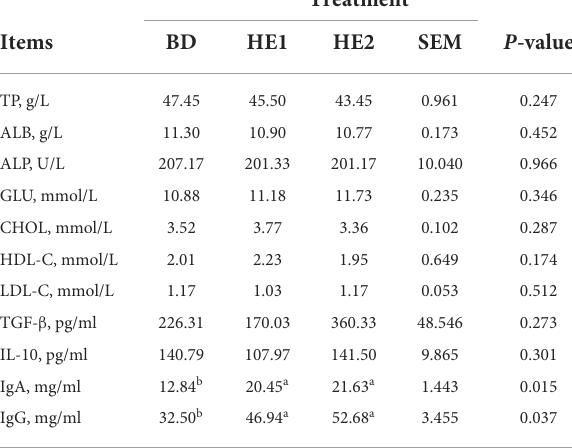
TABLE 4 Effect of HE on serum biochemical indexes a .